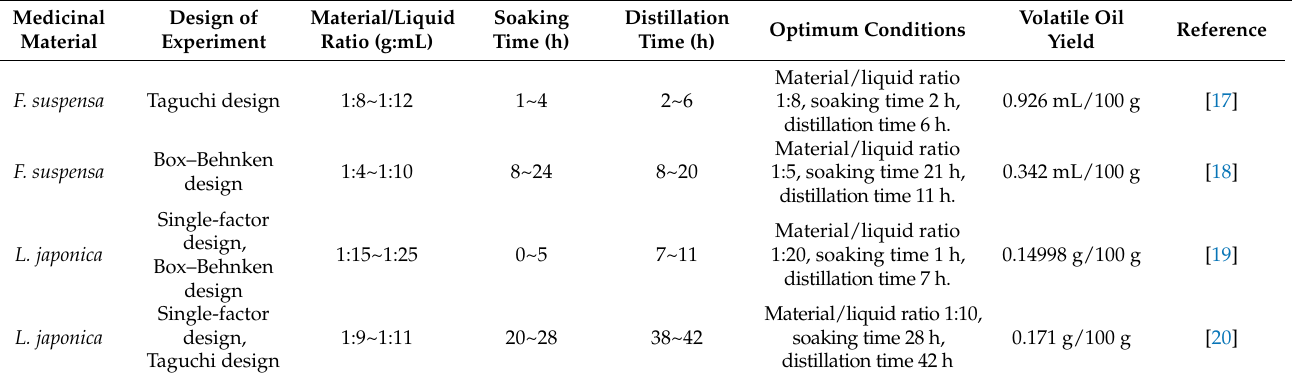
Table 1. Literature on steam